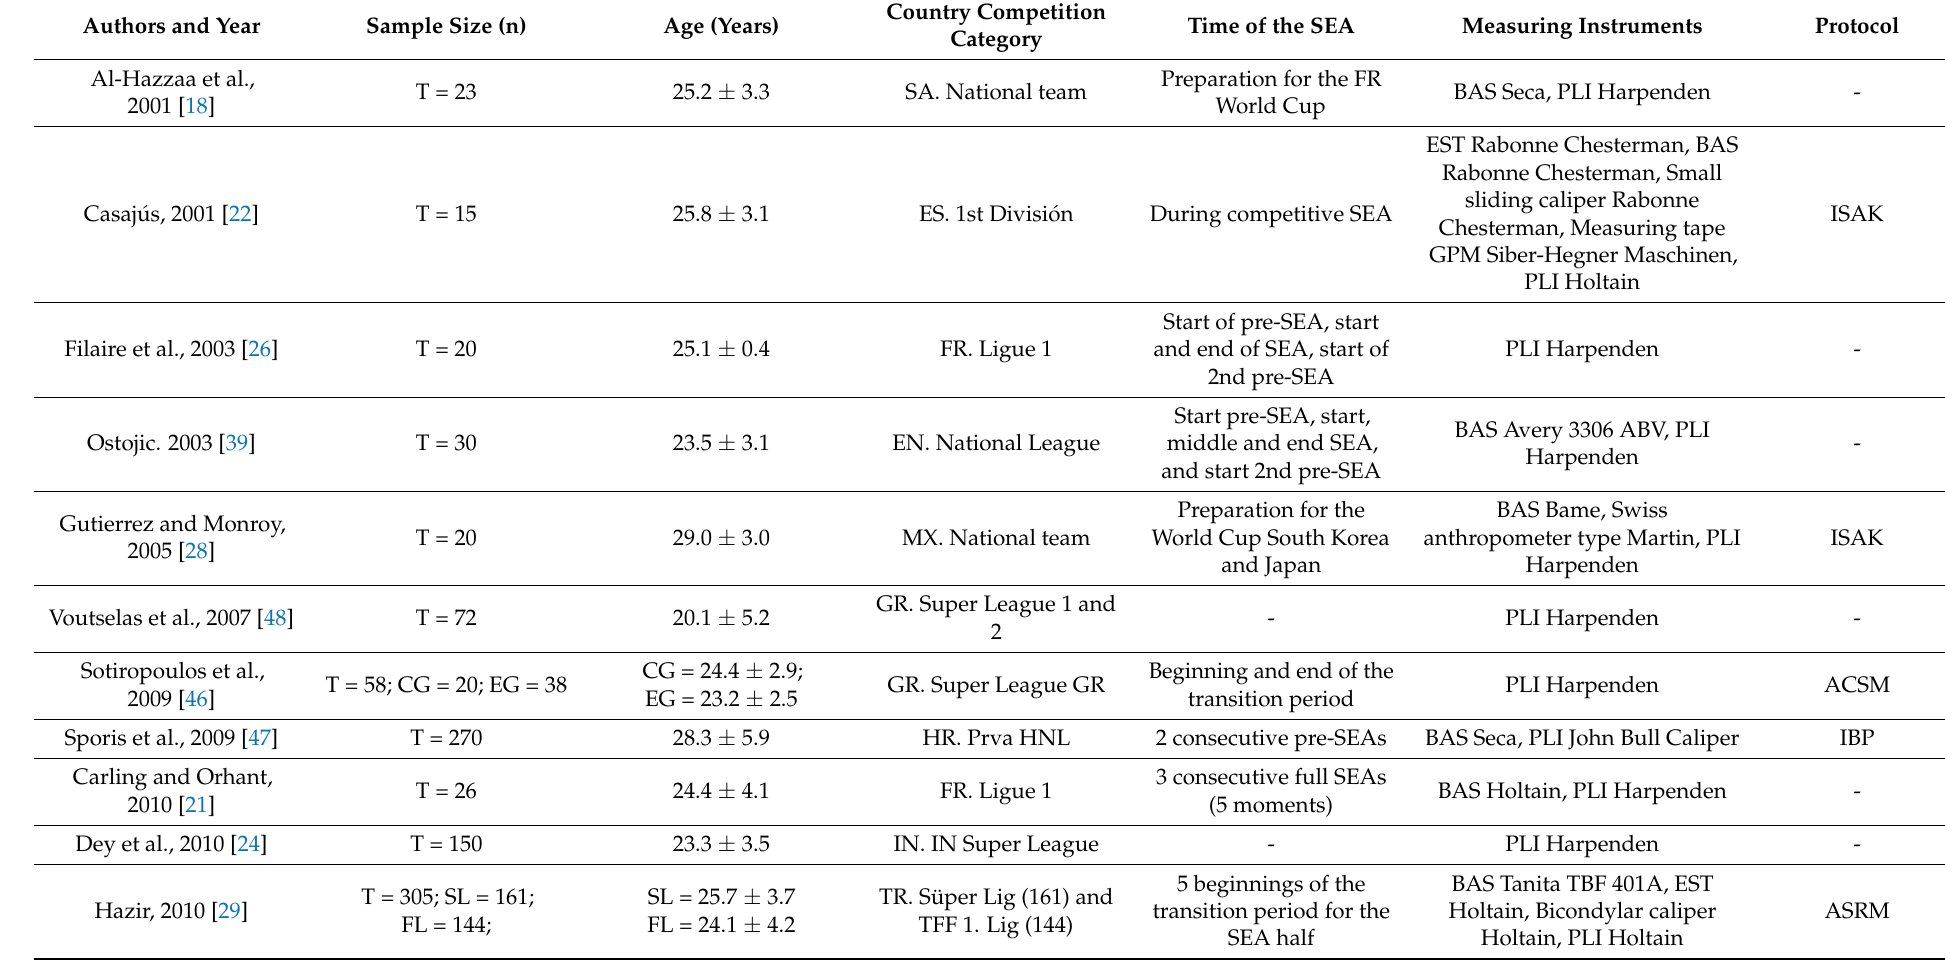
Table 2. Descriptive characteristics of the included studies with